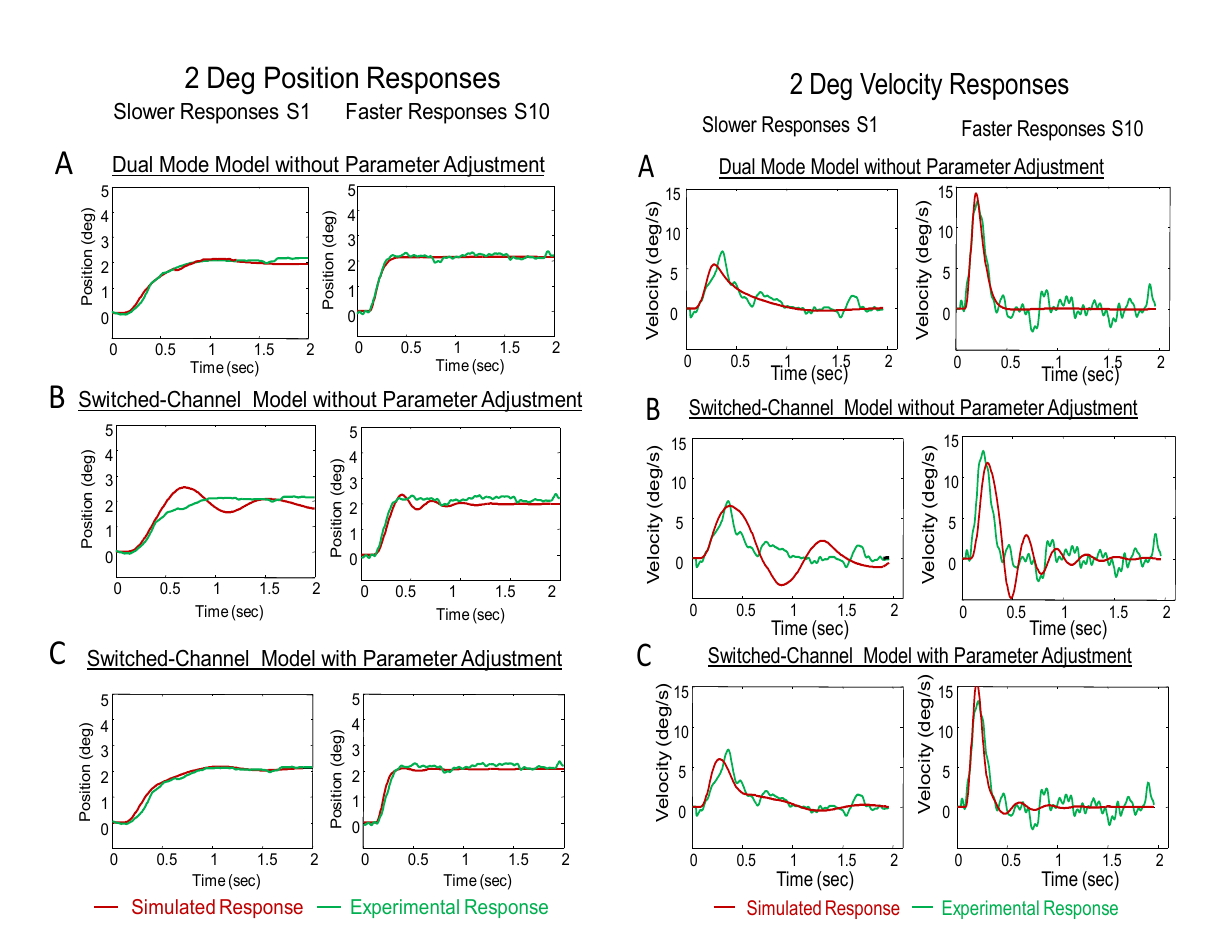
Figure 6: Comparison of dual-mode and switched-channel models simulation to a slower (left) response from subject S1 and a faster response (right) from subject S10. The simulation is shown in red and the experimental response is in green. The models were adjusted using 4  data then the amplitude of the response was decreased to 2  and compared to several 2  re- sponses. The response with the best fit is shown (Plot A for dual-mode and Plot B for switched-channel). The switched- channel model could represent the 2  response but only after parameter adjustment (Plot C). All models used the plant pro- posed by Robinson.